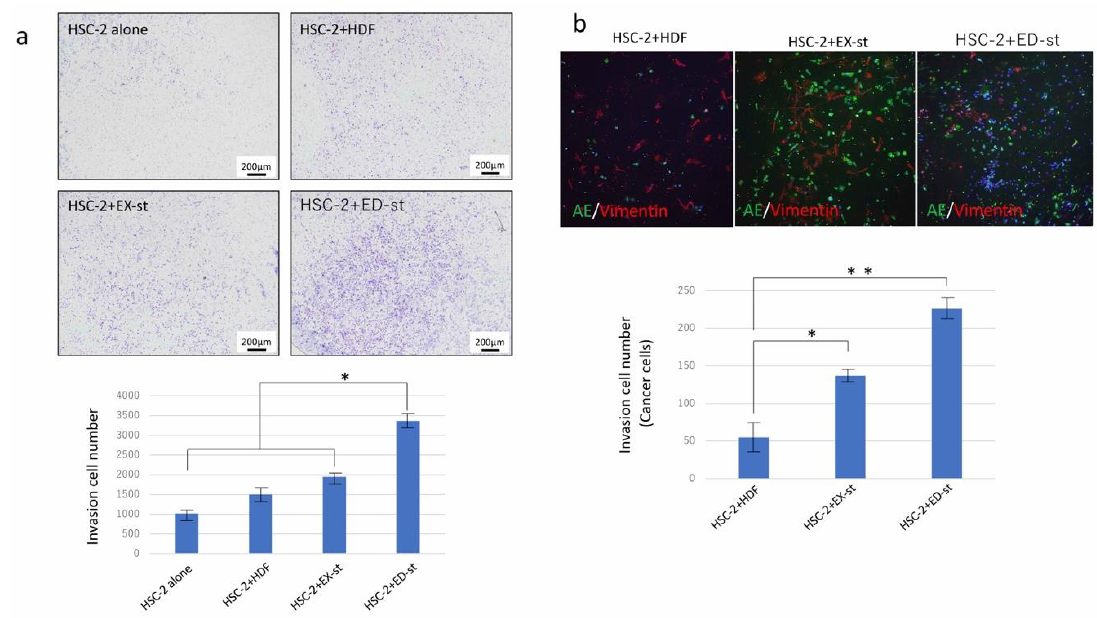
Figure 3. The tumor stroma promoted the invasive ability of HSC-2 cells in vitro. ( a ) Representative light microscopic images showing stained tumor stroma / HDFs and HSC-2 cells on the lower surface of the microporous transwell insert after invasion. The invasive ability of HSC-2 cells was strongly promoted when co-cultured with stromal cells compared to HDFs. ED-st in particular most strongly promoted the invasive ability of HSC-2 cells. n = 4. ( b ) Representative images of immunofluorescence staining of invading cells with vimentin (red) and α -SMA (green) staining and DAPI counterstaining (blue). The tumor stroma promoted the invasive ability of HSC-2 cells compared to HDFs, and ED-st most strongly increased the invasive ability of HSC-2 cells. n = 4, * p < 0.05, ** p < 0.01.